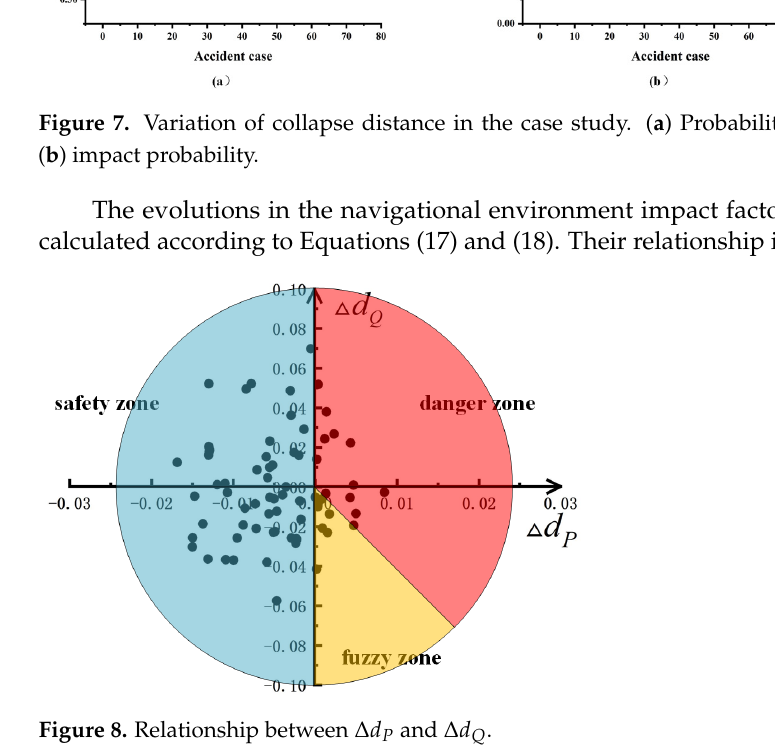
Figure 8. Relationship between